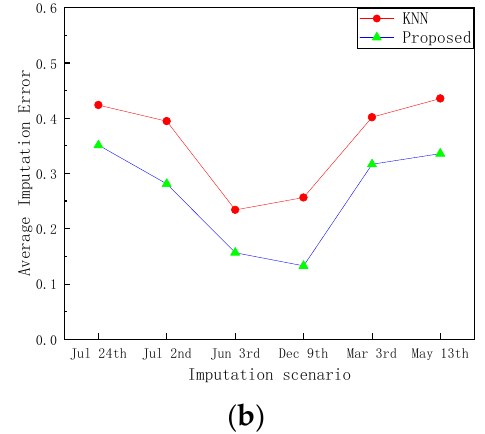
Figure 8. ( a ) Comparison between the filling results of the proposed method and KNN algorithm and the real value (scene on 24 July). ( b ) Comparison of average filling errors between the proposed method and KNN algorithm in partial filling scenarios .